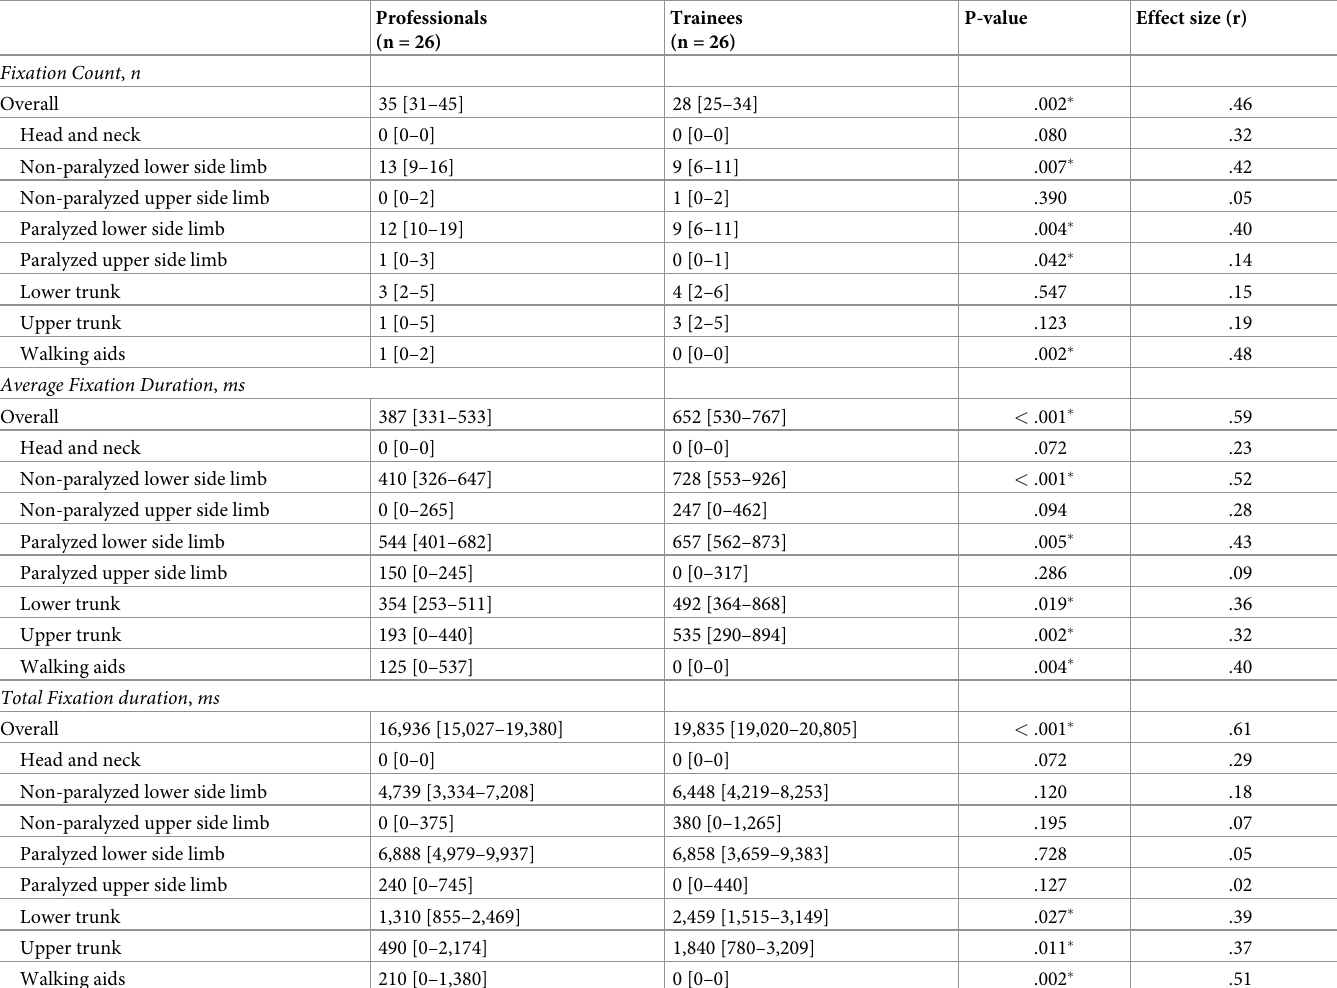
Table 2. Fixation parameters from eye